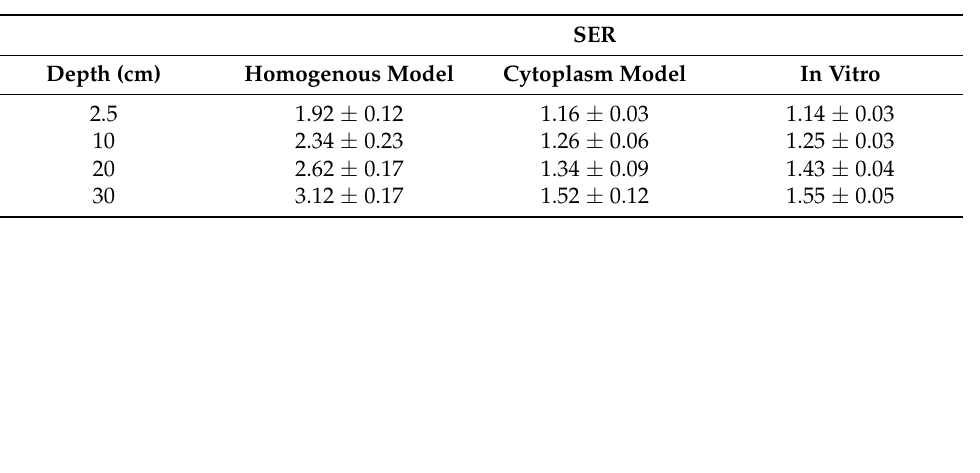
Table 4. Sensitization enhancement ratio (SER) calculated on MC-LEM survival fraction curves for both homogenous and cytoplasm cell models, compared against that from in vitro clonogenic